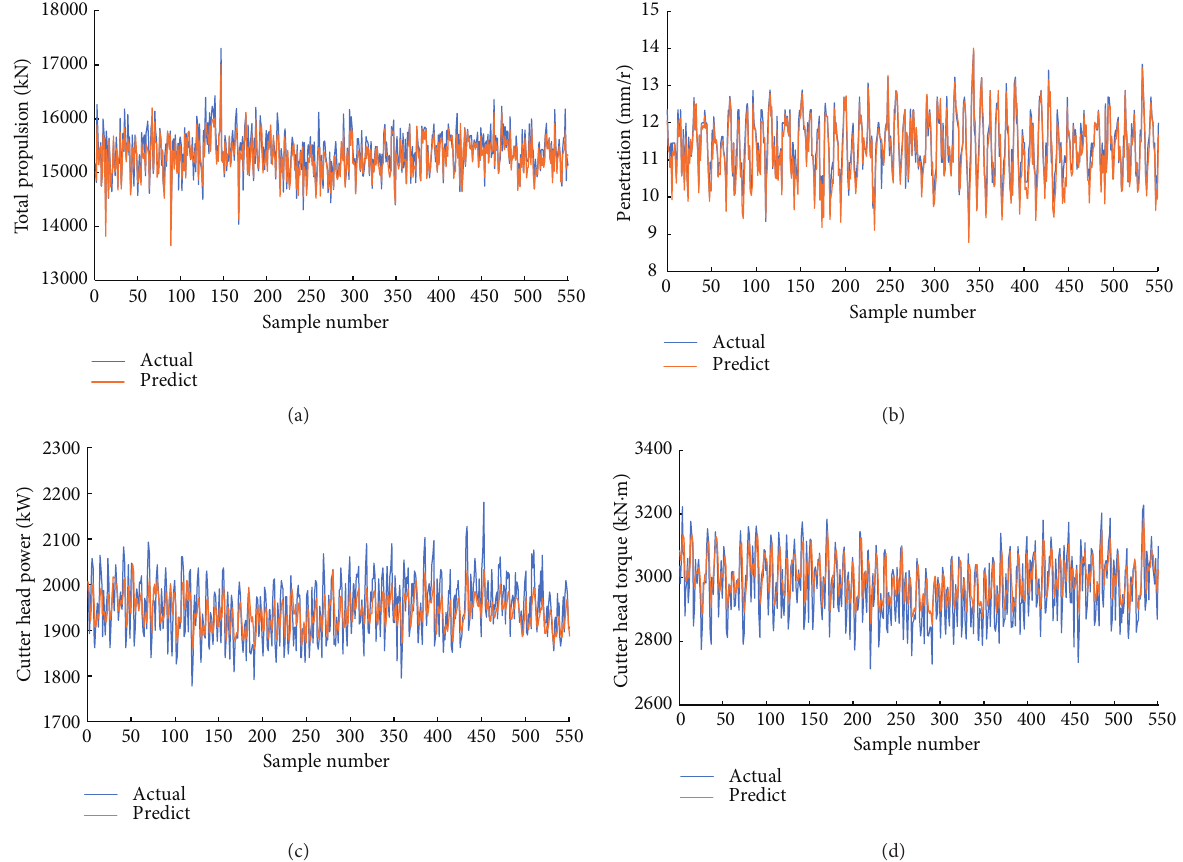
Figure 11: Prediction results of Bi-GRU model. (a) Prediction results of total thrust F . (b) Prediction results of penetration e . (c) Prediction results of cutterhead power P . (d) Prediction results of cutterhead torque T .